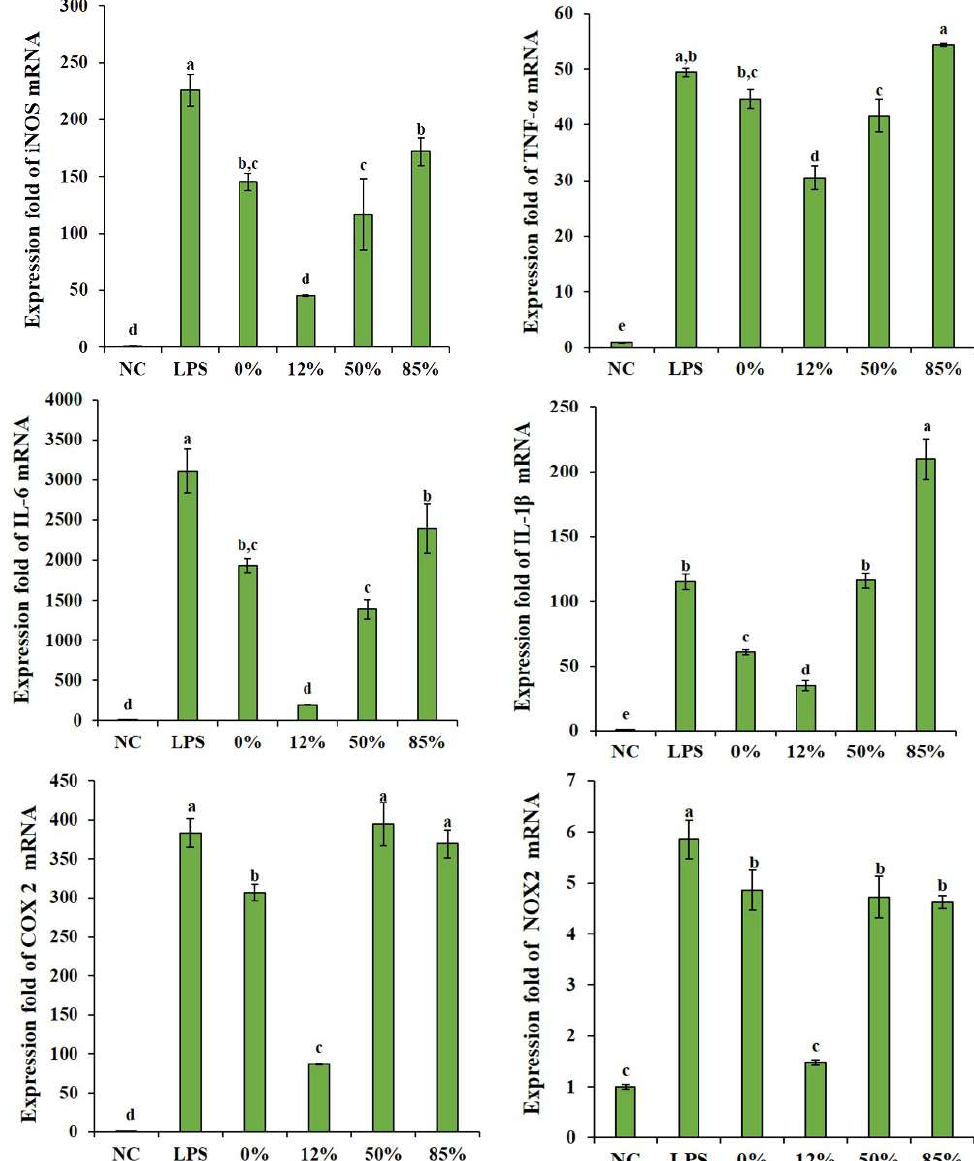
Figure 5. COS can reduce the up-regulation of several inflammation-related genes caused by LPS. 0%, 12%, 50%, 85% represent COS with DA of 0%, 12%, 50%, 85%, respectively. The data are presented as means ± SD of three replicates. From “a” to “e”, the mean values decrease in turn. There is no significant difference between groups with the same letter. Different letters indicate individual groups for multiple comparisons with significant differences (one-way ANOVA, Duncan, p < 0.05).